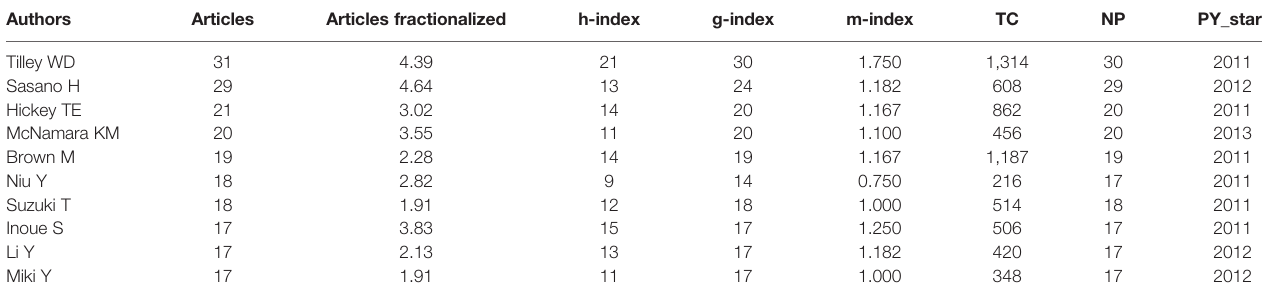
TABLE 5 | Top 10 contributing authors in the fi eld of androgen receptor and breast